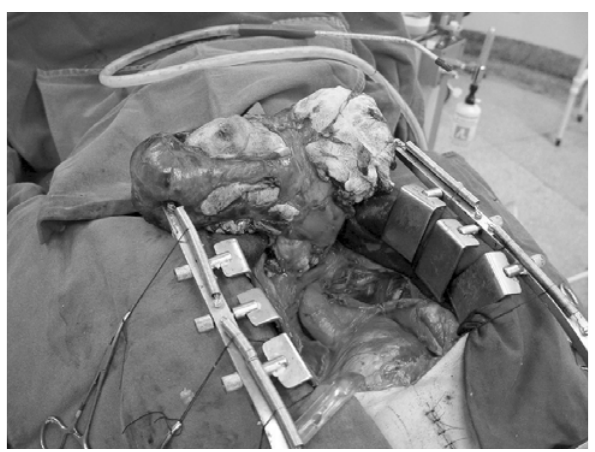
Fig. 2 - Imagem intra-operatória do tumor de mediastino